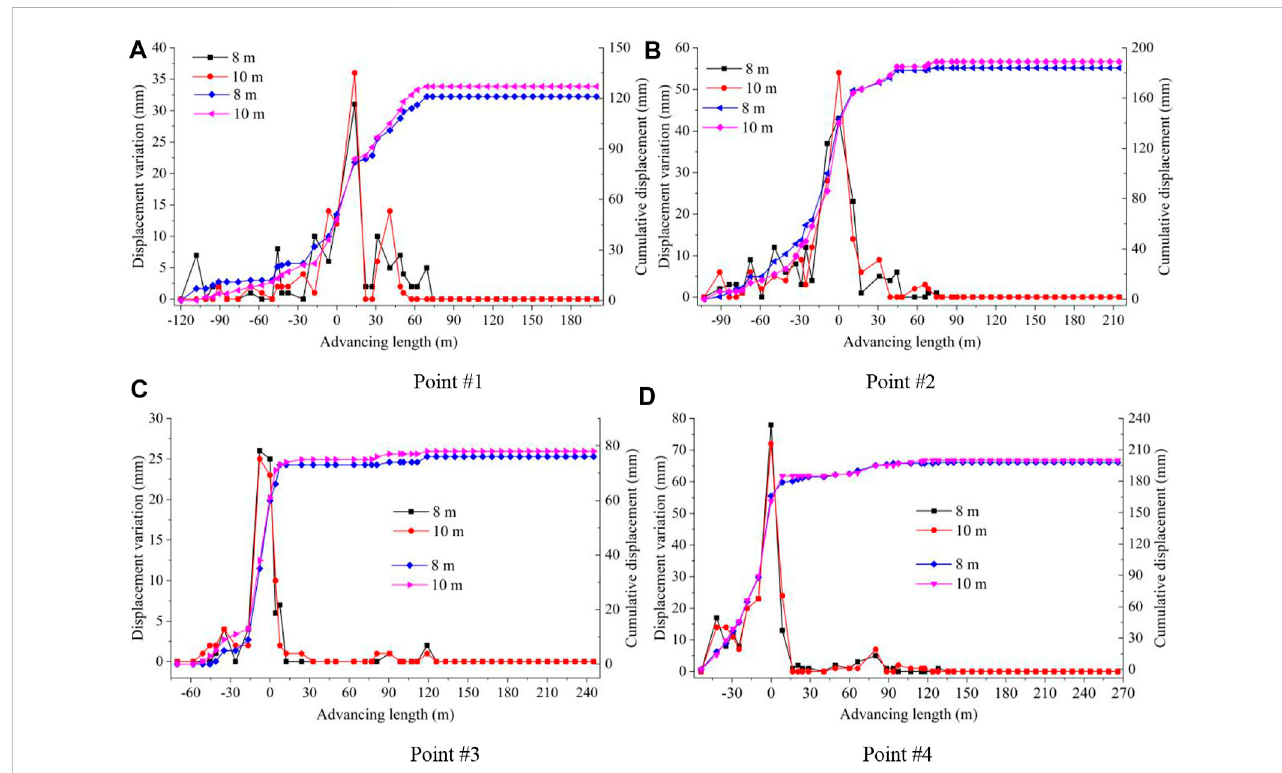
FIGURE 4 Relative displacement variations in rock strata at 8 m and 10 m from the roof. (A) Point #1. (B) Point #2. (C) Point #3. (D) Point